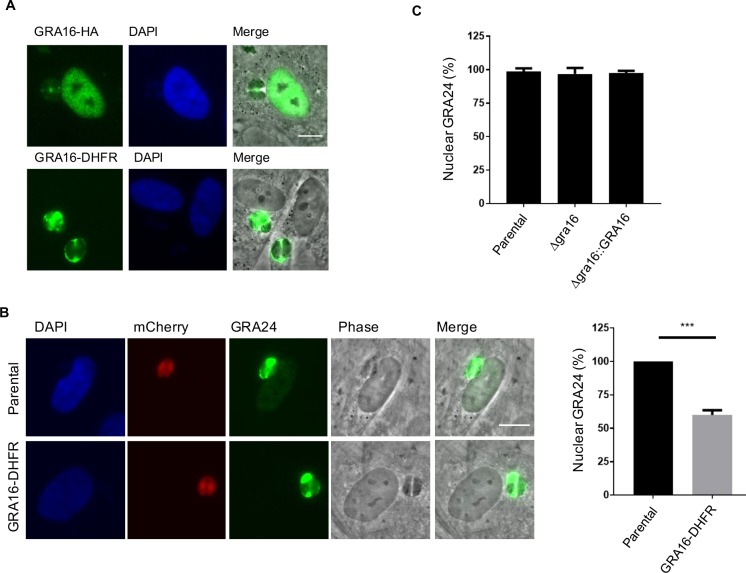
Fusion of GRA16 to DHFR domain blocks effector transport.(A) DHFR domain blocks GRA16 transport to host nucleus. HFFs were infected with RH tachyzoites ectopically expressing GRA16-HA or GRA16-DHFR and fixed at 20 hpi. GRA16-HA was stained with anti-HA antibodies and GRA16-DHFR was stained with anti-DHFR antibodies. (B) GRA16-DHFR expression reduces GRA24 transport to the nucleus. Parental RH and RH::GRA16-DHFR tachyzoites were transiently transfected with GRA24-Myc plasmid and fixed at 20–24 hpi. GRA24 was stained with anti-Myc tag antibodies and its localization to the host nucleus was quantified. The averages are based on normalized results from three independent experiments. Error bars indicate standard error of the mean, and statistics were performed with Student’s t-test. *** indicates P < 0.001. (C) GRA24 localization to host nucleus does not depend on GRA16 translocation. HFFs were infected with RH wild type, RHΔgra16, and RHΔgra16::GRA16-HA tachyzoites transiently expressing Myc-tagged GRA24 and fixed at 20–24 hpi. Staining of the host nucleus with antibodies to the Myc-tag is expressed as a percentage of all cells infected with parasites expressing the GRA24 construct. Results are shown for one representative experiment of 3 performed. Scale bar indicates 5 μm.